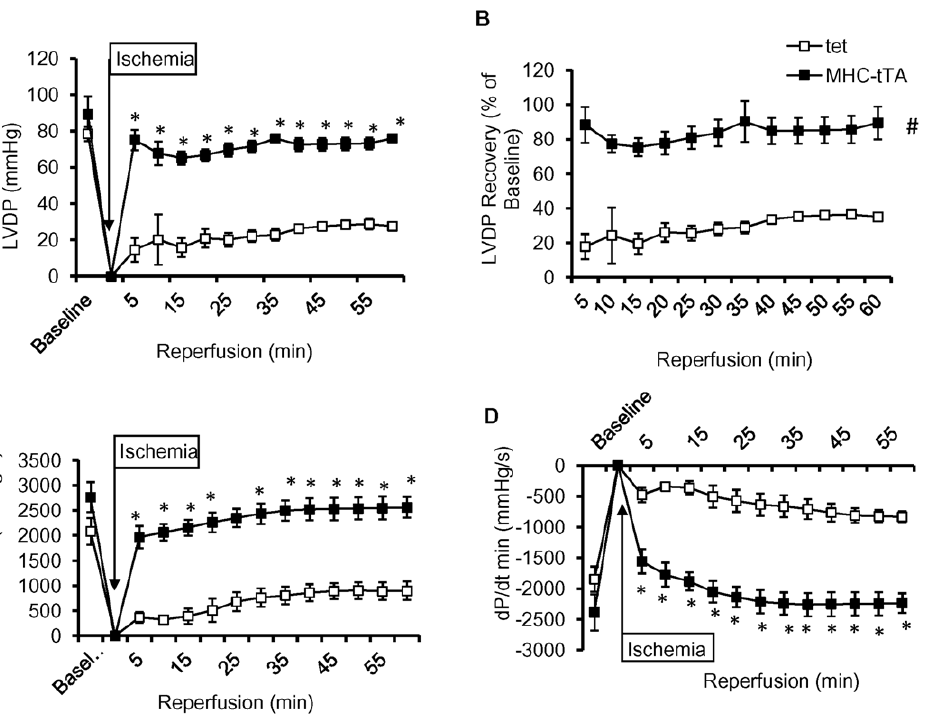
Figure 1. a -MHC-tTA hearts were protected against I/R injury invitro using the Langendorff-perfused heart. (A–B) LVDP was similar between a -MHC-tTA and control hearts at baseline; however, after 30 min of ischemia, control hearts recovered to 35% of baseline LVDP values whereas a -MHC-tTA had 90% recovery. (C–D) LV systolic and diastolic functions assessed by dP/dt max and dP/dt min respectively were significantly higher in a -MHC-tTA compared to control after 30 min of ischemia. (N=3 for control and N=4 for a MHC-tTA, p , 0.05).